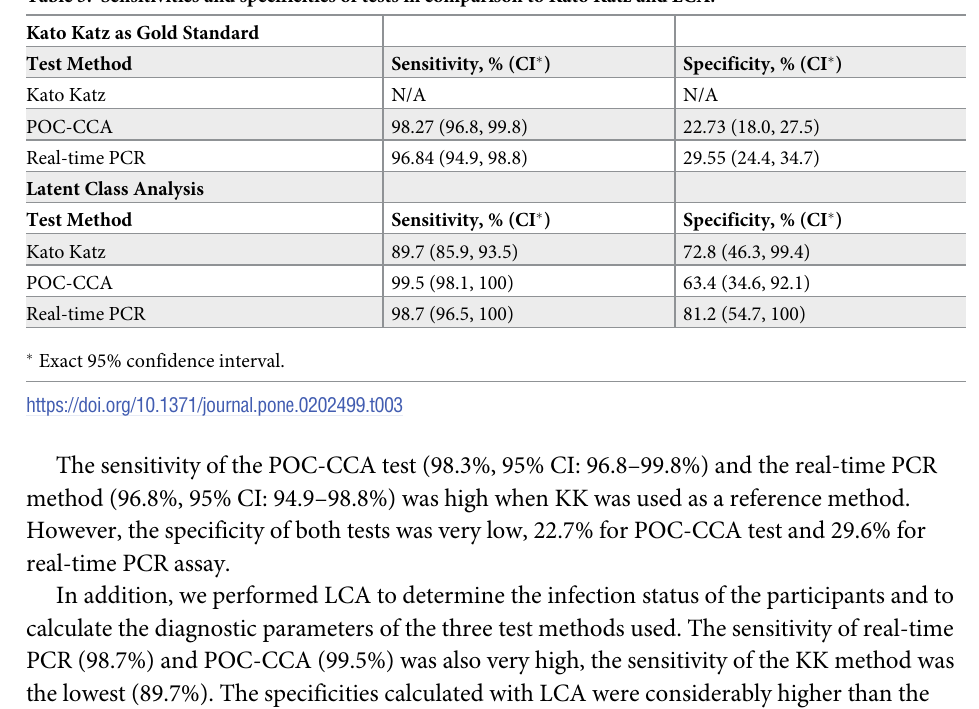
Table 3. Sensitivities and specificities of tests in comparison to Kato Katz and